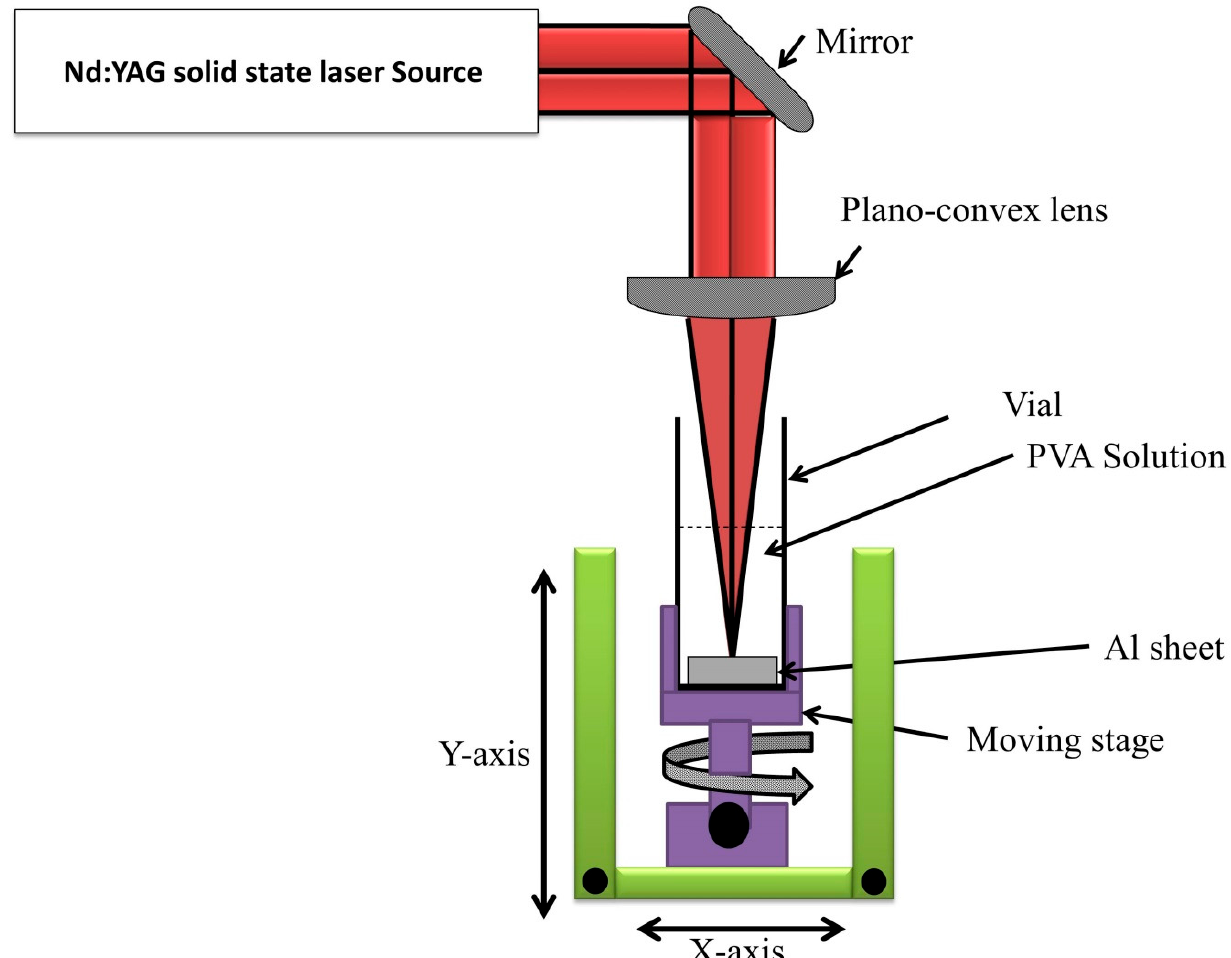
Figure 1. Schematic diagram of Al 2 O 3 -PVA nanocomposite by PLAL.